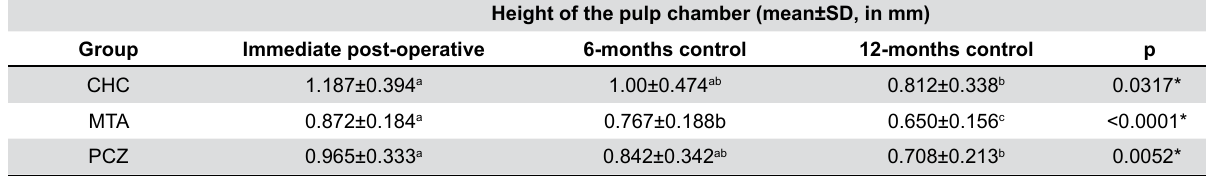
Table 3- Intragroup comparisons of the pulp chamber height (ANOVA followed by Tukey’s test,